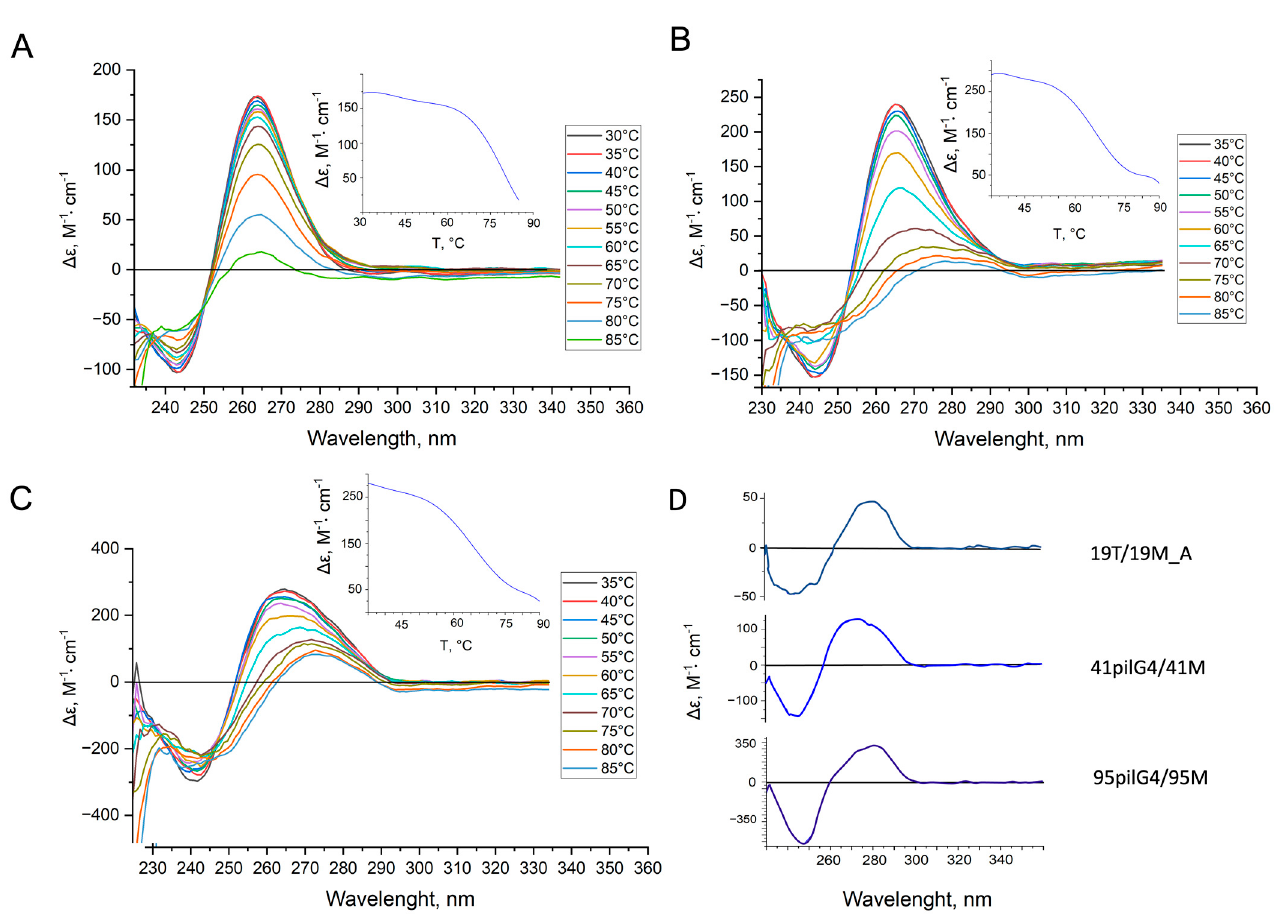
Figure 3. Schematic representations and abbreviations of DNA duplexes (right) formed by hybridi- zation of oligonucleotides (left). The oligonucleotide sequences are shown in Table 1.